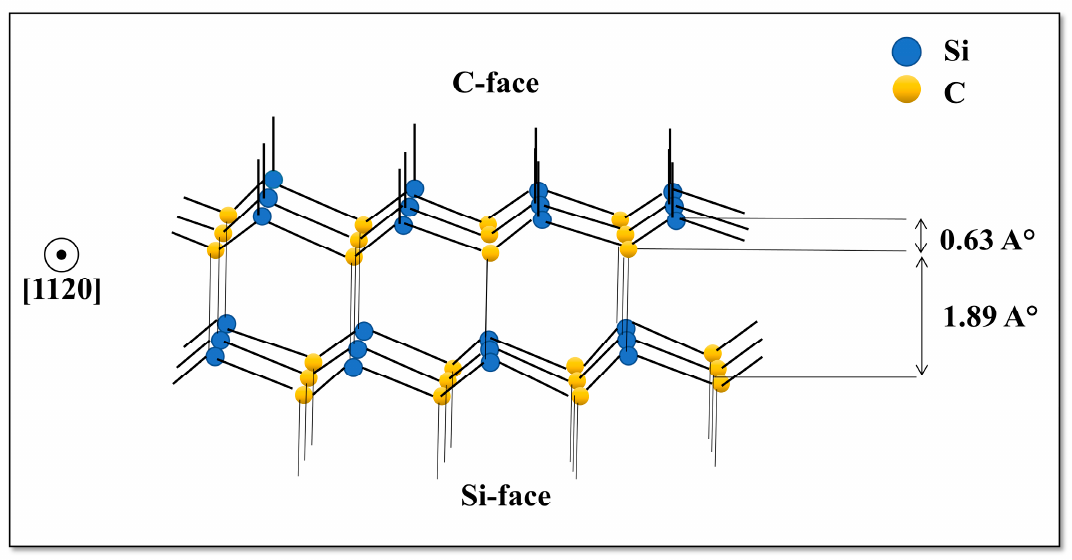
Figure 4. Schematic representation for the two different Si and C termination faces of the hexagonal polytype of SiC crystals, with orientation (0001) and (000-1), respectively. Si atoms are shown in blue, C atoms are shown in yellow. The C terminated face is located at the top and the Si terminated face is located at the bottom of the structure diagram.